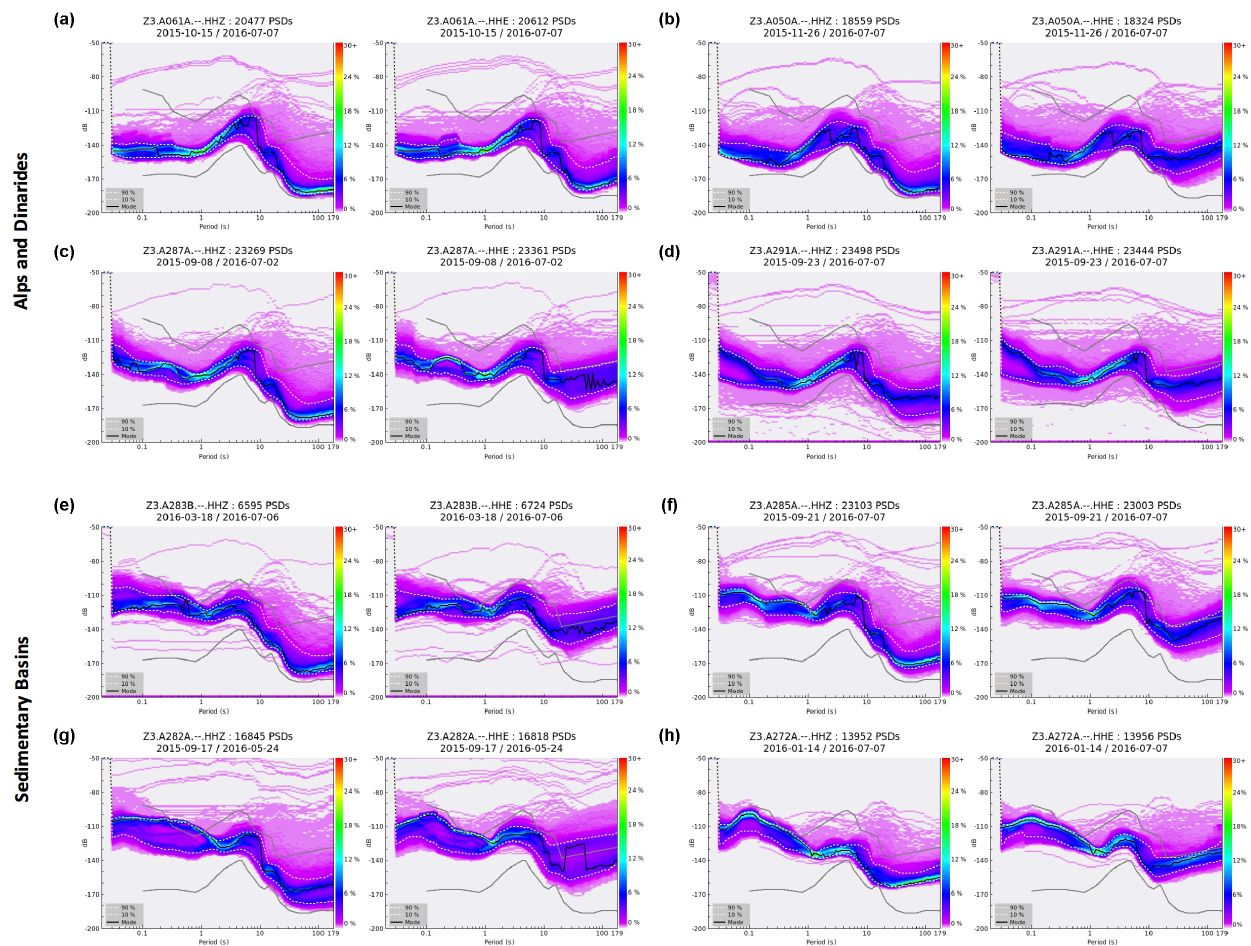
Figure 5. PDF of vertical and E-W components for the site A061A (a) , A050A (b) , A287A (c) , A291A (d) , A283B (e) , A285A (f) . A282A (g) , A272A (h) . Data is from the entire operational period of each station: from the installation (Table 1) to the beginning of July 2016, with the exception of A282A for which the data is shown until the end of May 2016. The first four sites are located in the Alps and Dinarides while the last four are in the Po Plain and the Pannonian basin. All the stations are equipped with STS-2 sensors with the exception of A272A where a Trillium Compact 120 s is installed. For a description see Sect.